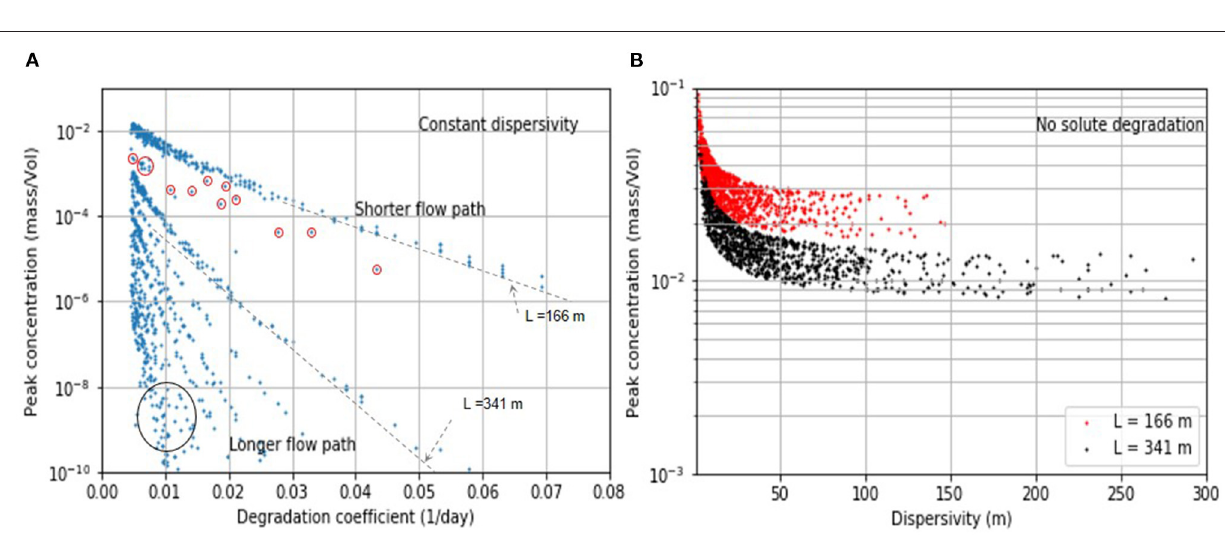
variations in peak concentration for a given dispersivity value is attributed to variable input concentrations and flow rates (the data represents a band not a